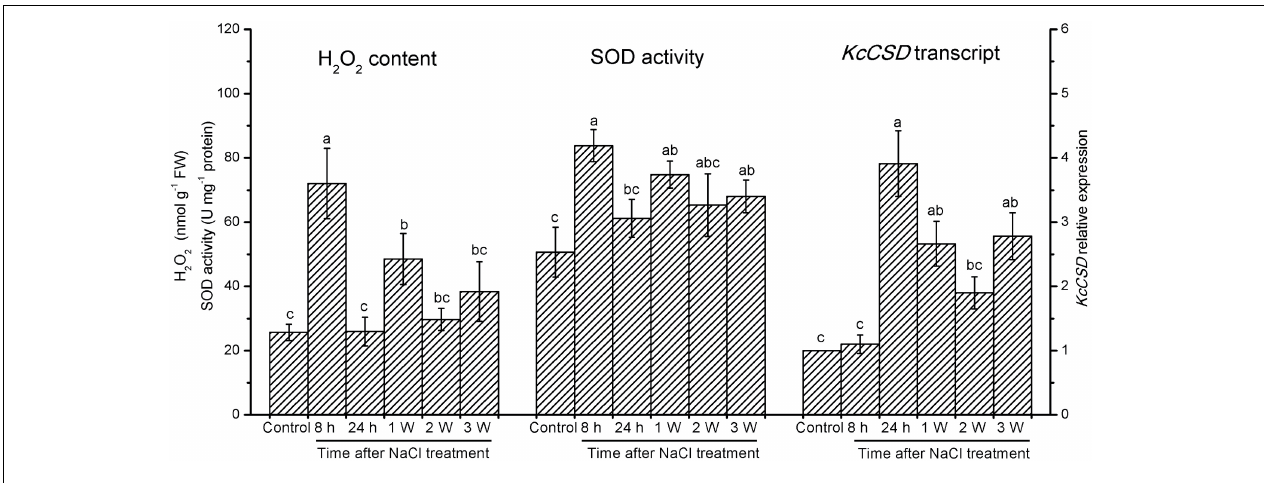
weeks. Each column is the mean of 4–6 replicates. Bars represent standard error of the mean. Different letters above columns represent significant differences at P < 0 . 05 during